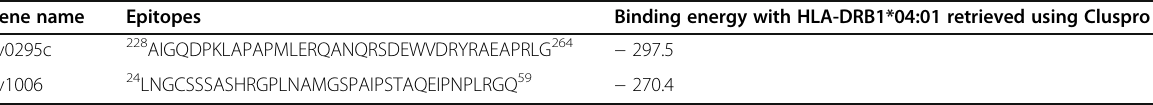
Table 2 Binding energy for the epitopes-HLA-DRB1*04:01